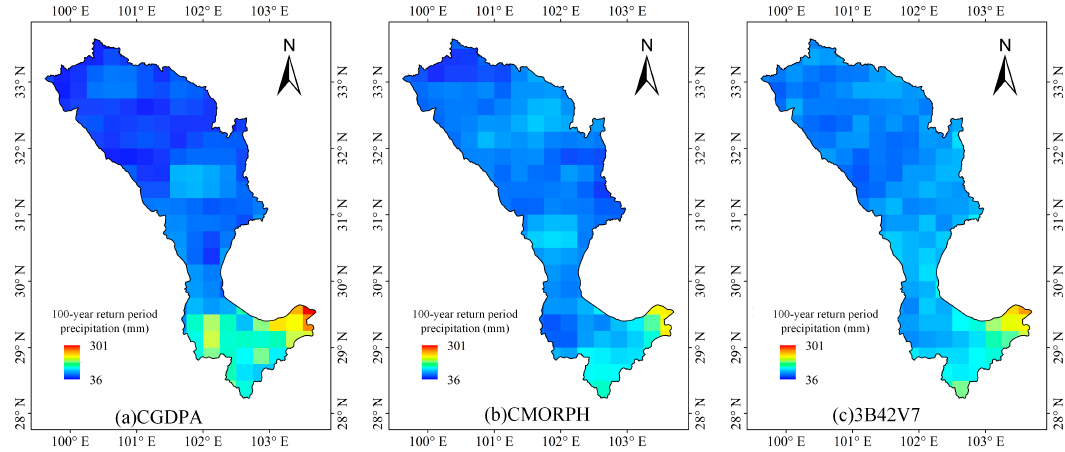
Figure 12. Spatial distribution of 100-year return period precipitation estimation: ( a ) CGDPA; ( b ) CMORPH; and ( c ) 3B42V7.